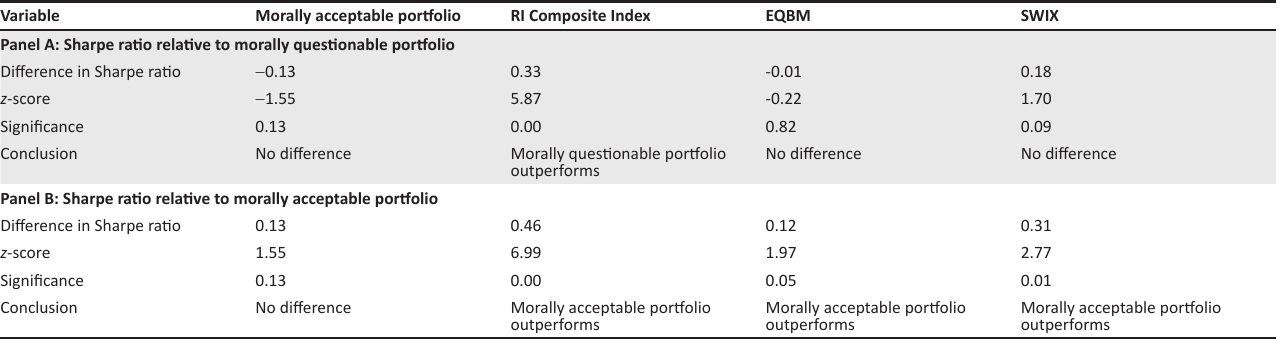
TABLE 5: Tests for significant differences in the Sharpe ratio.